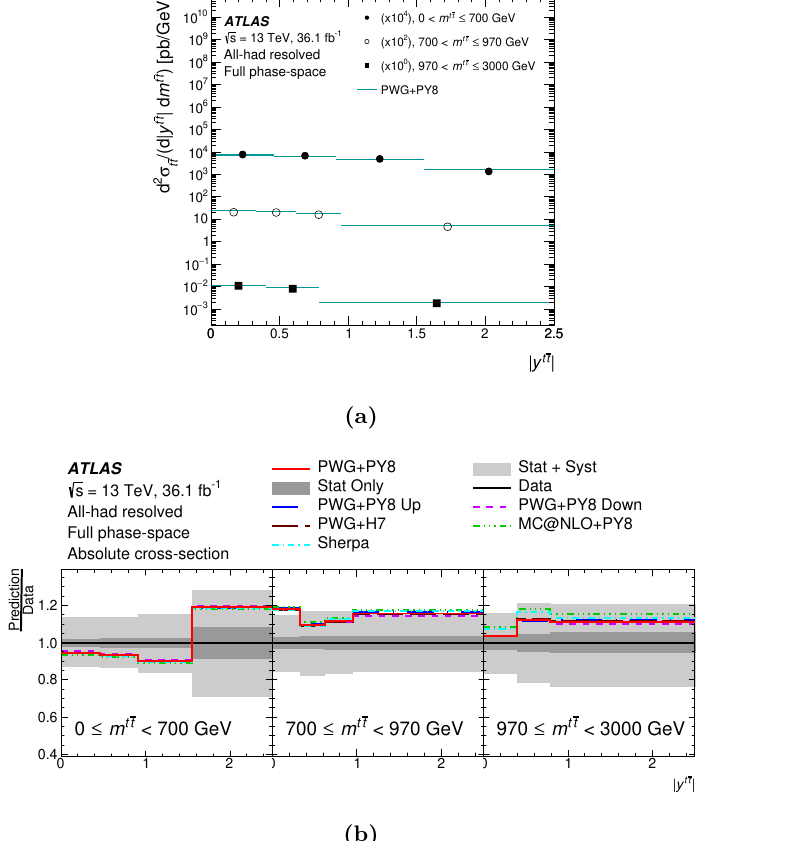
Figure 21 . Parton-level double-differential absolute cross-section (a) as a function of the t ¯ t system rapidity in bins of the t ¯ t system mass, compared with the nominal Powheg+Pythia 8 prediction without uncertainties. Data points are placed at the centre of each bin. Different markers are used to distinguish the three bins in m t ¯ t , while y t ¯ t is shown on the horizontal axis. The ratio (b) of the measured cross-section to different MC predictions. Uncertainties are shown by the shaded